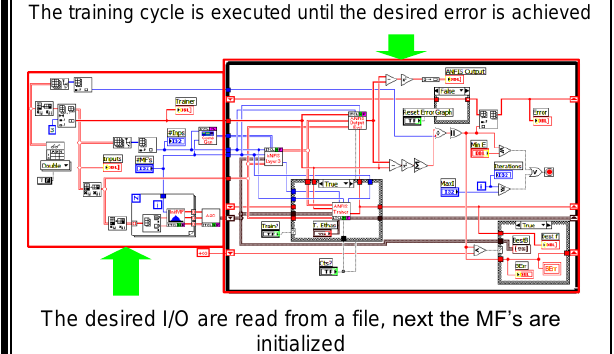
Fig. 8 . LabVIEW block diagram code of proposed MISO ANFIS controller in training phase